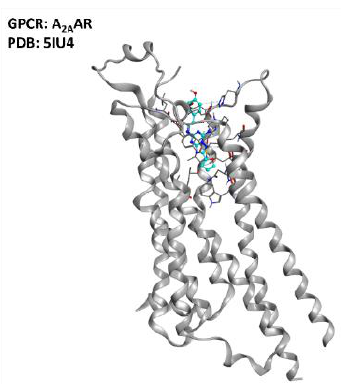
Figure 3. Representation of the structure of the A 2A AR receptor (sourced from the Protein Data Bank [97], PDB code: 5IU4 [98], method: X-ray diffraction, resolution: 1.72 Å ). The image was created and rendered with the Molecular Operating Environment (MOE) suite [99].